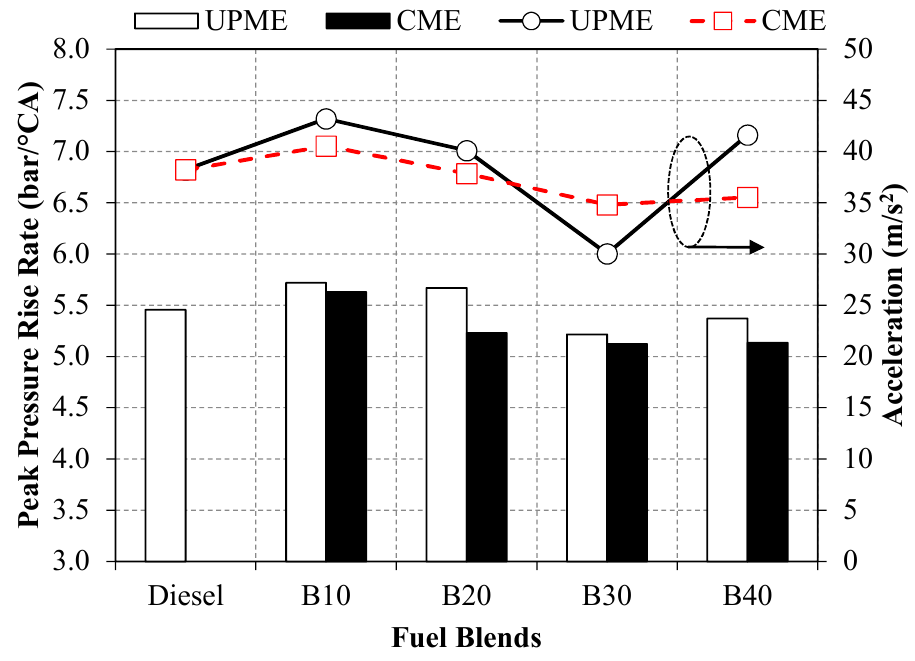
Figure 7. Rate of increase in peak pressure and the root mean square (RMS) of acceleration for all UPME and CME fuel blends as compared to the standard diesel.